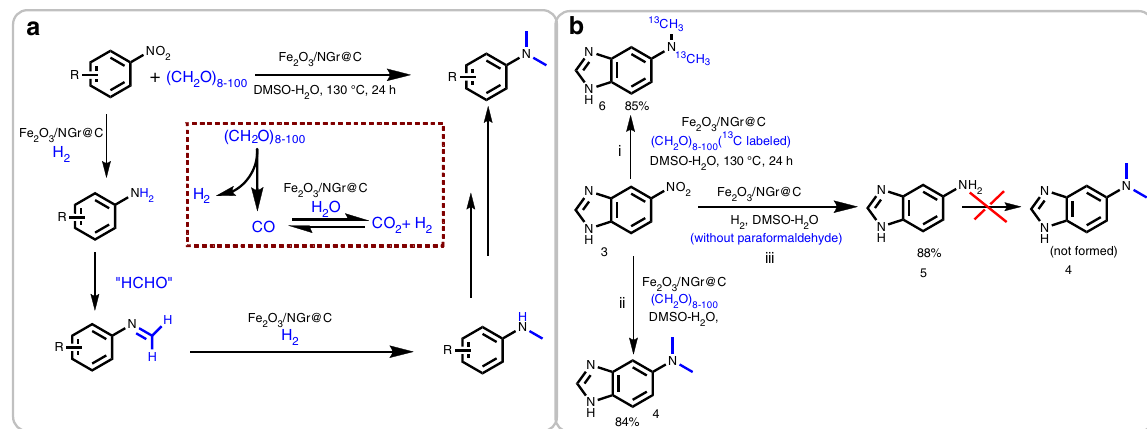
Fig. 9 Iron-catalyzed reductive N -methylation a . a Reaction pathway showing stepwise reductive methylation of nitro compounds. b 13 C-Labeled experiment showing paraformaldehyde as C1 source i,ii,iii . Reaction conditions: i 0.5 mmol of 5-nitrobenzimidazole, 10 mmol of 13 C-labeled paraformaldehyde (300